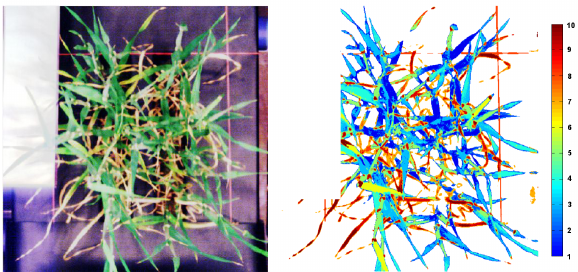
Figure 1: RGB visualization and labeling of a hyperspectral im- age of an barley